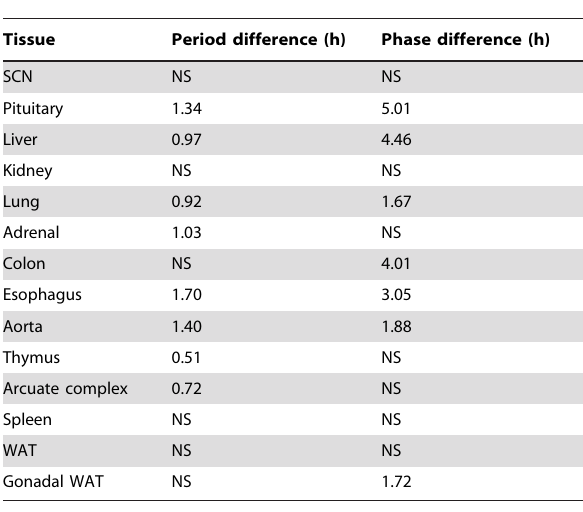
Table 1. Tissue-specific differences in periods and phases between wild-type and Per3 2 / 2